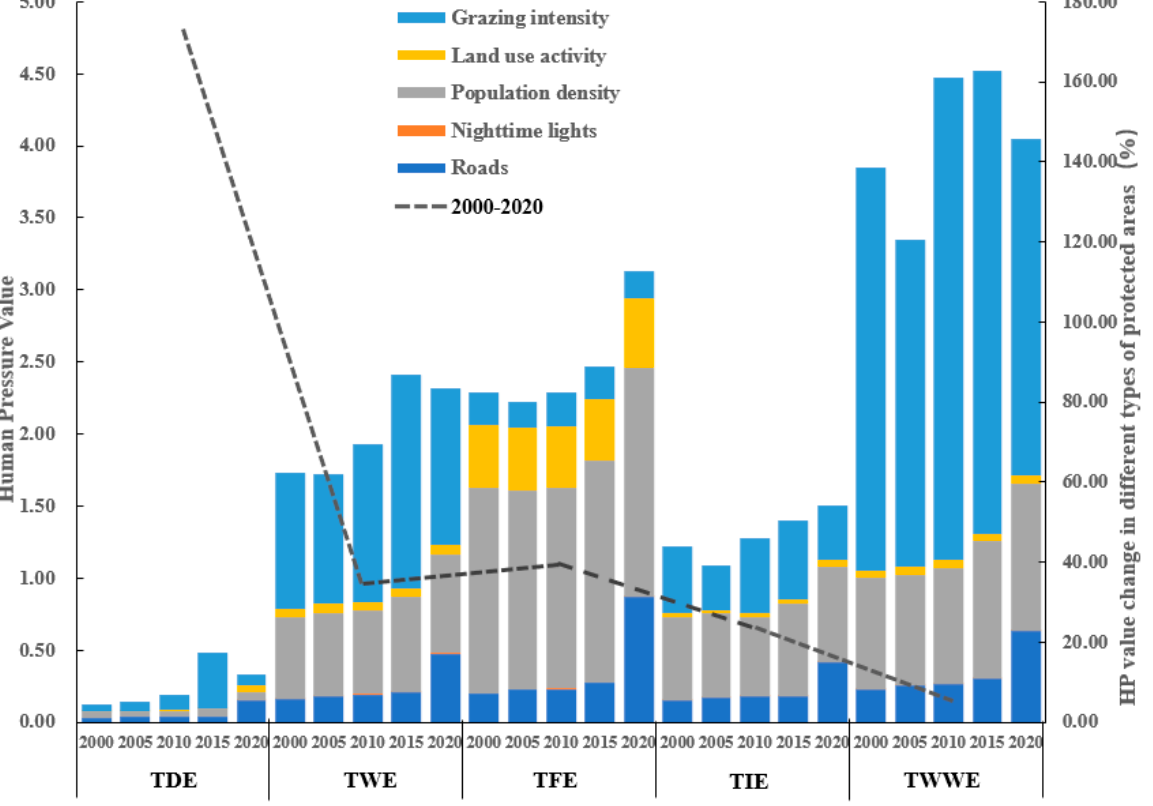
Figure 6. Temporal variation in HP in di ff erent types of the NRs for 2000–2020.